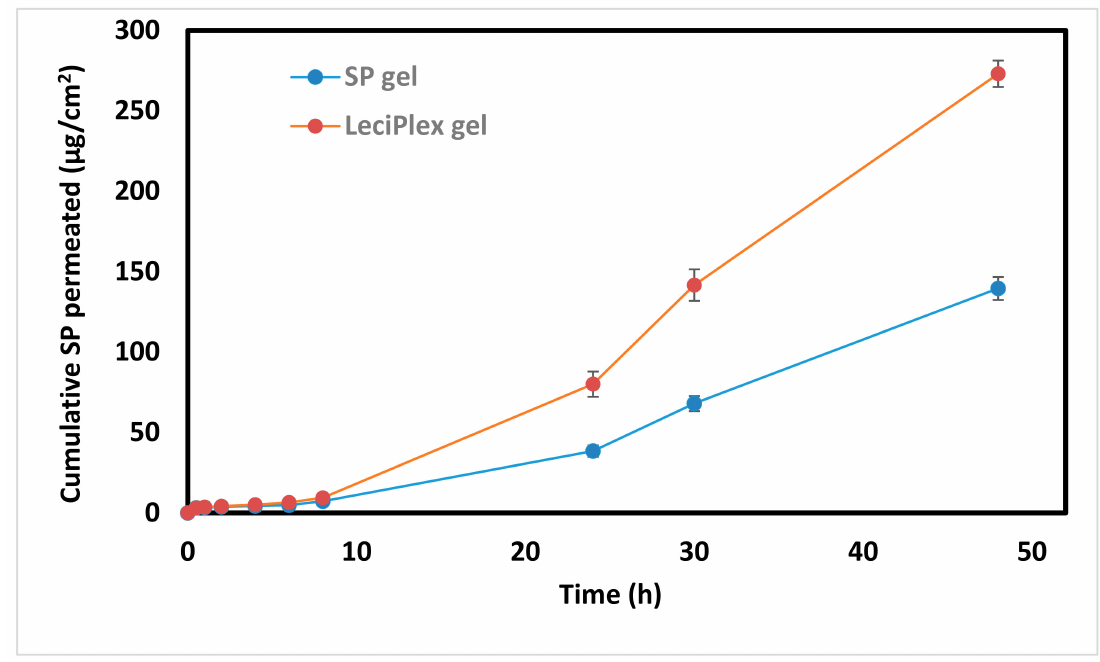
Figure 5. Ex vivo permeation of SP through excised rat abdominal skin from SP gel and SP LeciPlex gel as a function of